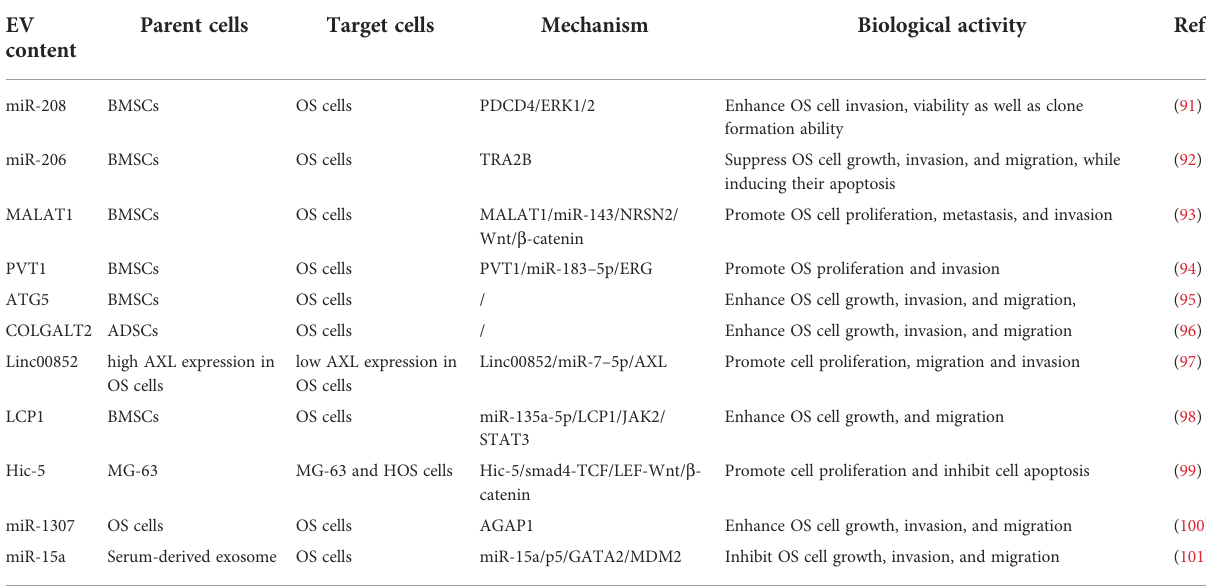
TABLE 1 Biological activity of exosomes in OS proliferation.